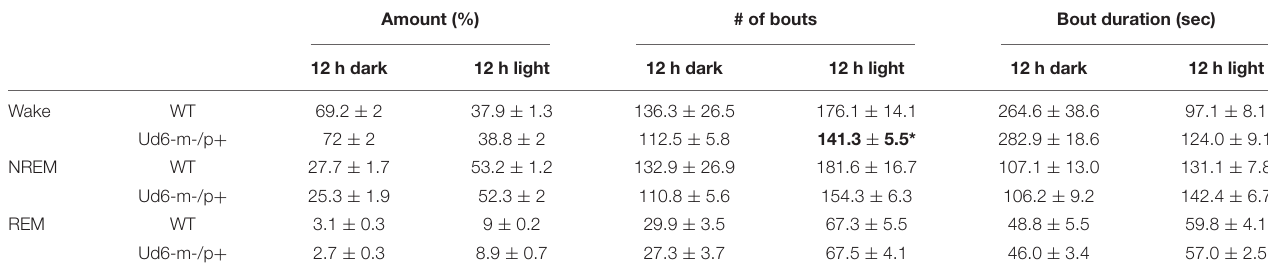
TABLE 1 | The number and duration of sleep and wake bouts in WT and Ud6-m-/p + mice in LD without access to a running wheel (mean ± SEM, * p < 0.05). Amount (%) # of